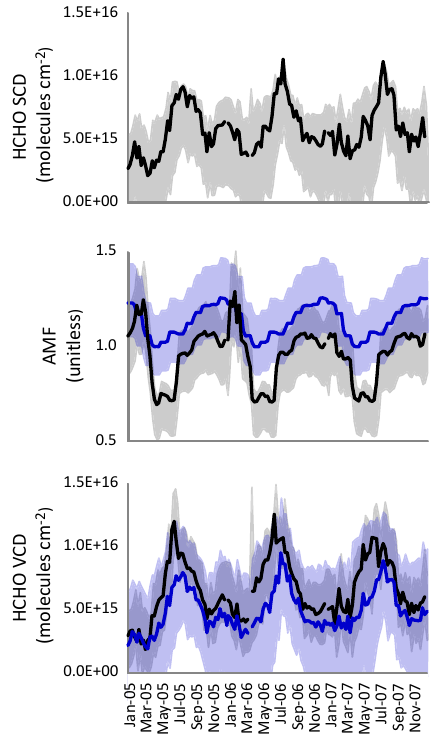
Fig. 2. Time series of 8-day averaged OMI HCHO (a) slant column density, (b) air mass factor, and (c) vertical column density from January 2005 to December 2007 for the standard (black) and cor- rected (blue) datasets. The data was averaged over entire Mediter- ranean Sea. Shaded area represents one standard error about mean